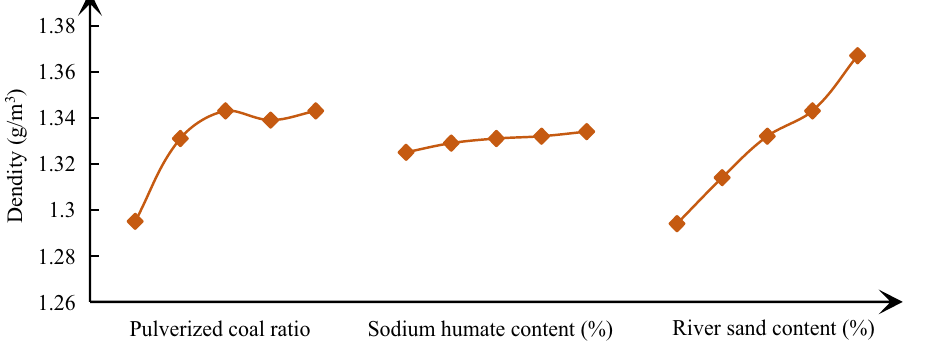
Figure 4. Effect curve of similar material density.